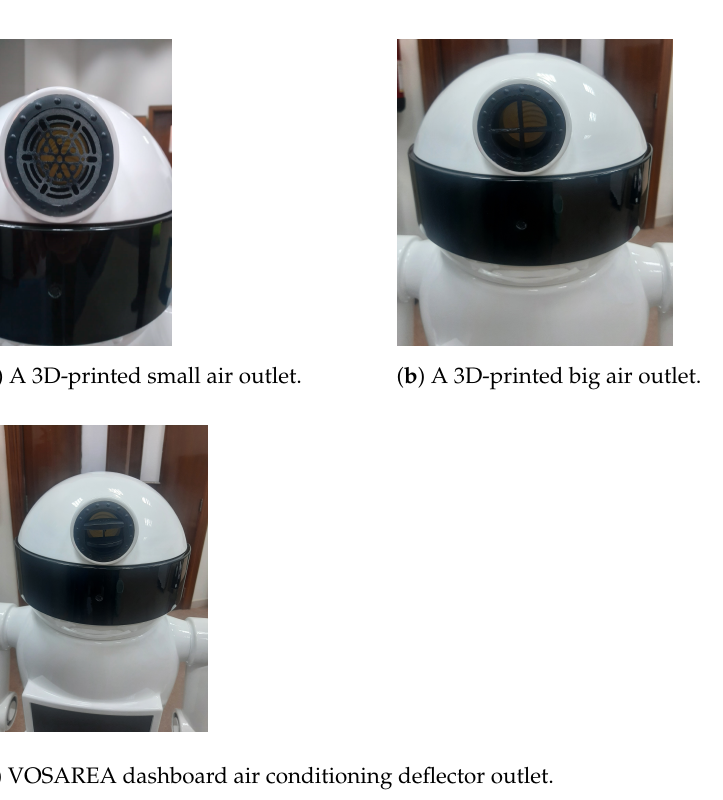
Figure 19. Different air outlets.